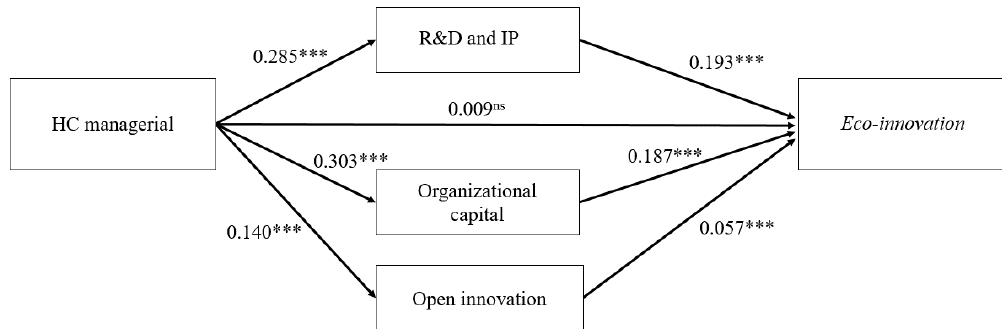
Figure 3: Effects of HC Strategic and Other Intangible Assets on Eco-innovation